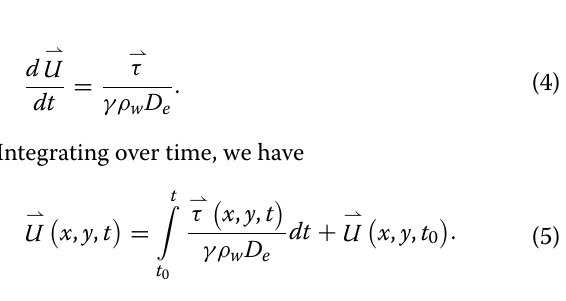
0 h; ( b ) and ( f ) t 4 h; ( c ) and ( g ) t 8 h; ( d ) and ( h ) t 12 h. Color indicates the power intensity (Unit: W · m − 2 = = = =